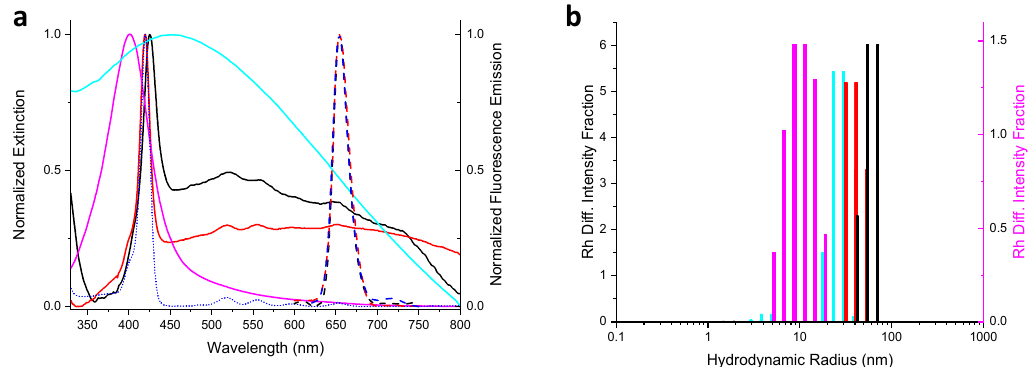
Figure 4. ( a ) UV-Vis spectrum of AgNPs (water, magenta line), P(PEG350) 3 (acetone, dotted blue line), AgNP@ClPT (acetone, cyan line), AgNP@P(PEG350) 3 in acetone (red line) and water (black line). Fluorescence emission spectra ( λ exc = 420 nm) of P(PEG350) 3 (acetone, blue dashed line), AgNP@P(PEG350) 3 in acetone (red dashed line) and water (black dashed line, overlapped with the blue one). ( b ) Hydrodynamic radius distribution of AgNPs (water, magenta), AgNP@ClPT (acetone, cyan), AgNP@P(PEG350) 3 in acetone (red) and water